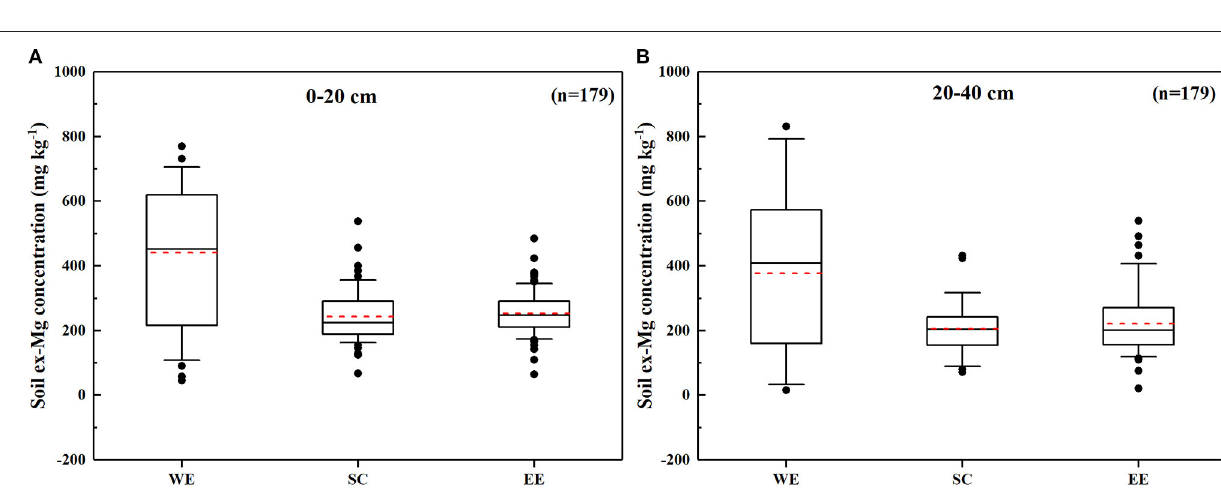
FIGURE 3 | Paddy soil ex-Mg concentrations of the (A) 0–20cm and (B) 20–40cm soil layers in different regions of Heilongjiang Province. Solid black and dashed red lines indicate the median and mean, respectively. The box boundaries indicate the 75% and 25% quartiles; error bars indicate the 90th and 10th percentiles; the black dots indicate extreme values. WE, western part; SC, south-central part; EE, eastern